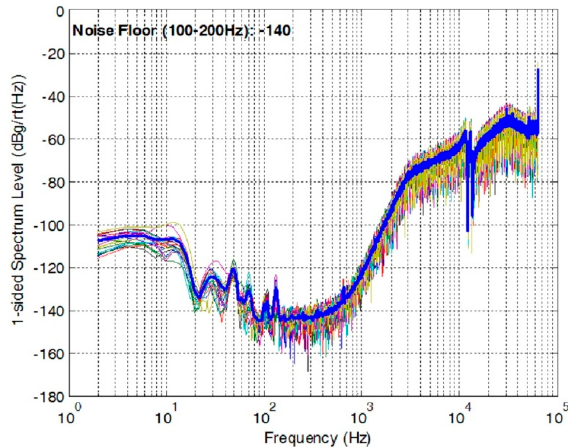
Figure 11. Noise PSD of a closed-loop accelerometer at room temperature. Table 2. Results between simulation data and measured data.